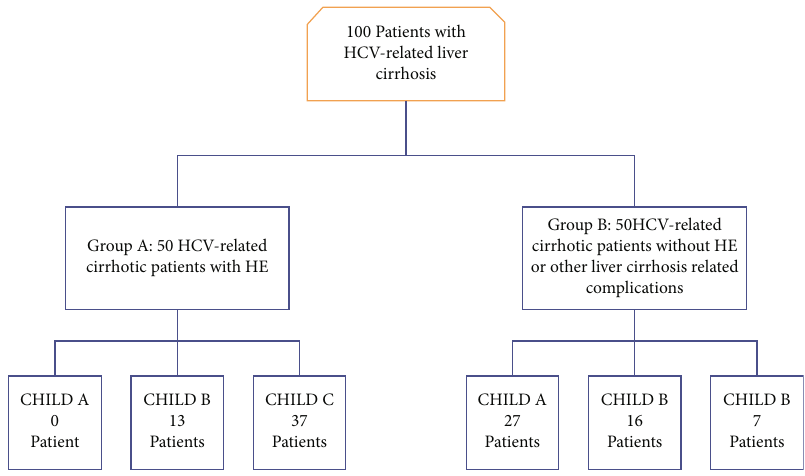
Figure 1: Patient selection fl owchart (A fifi , Hussein, and Rizk,